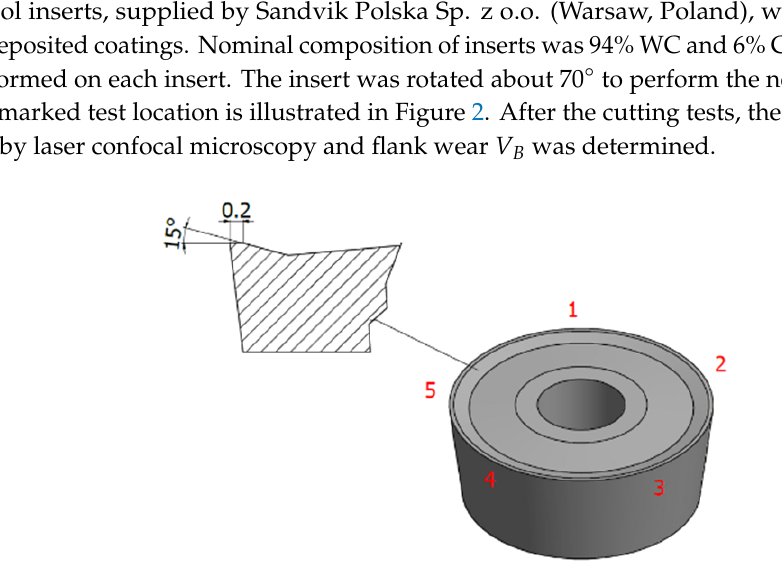
Figure 1. Stand for determination of wear at sliding friction.